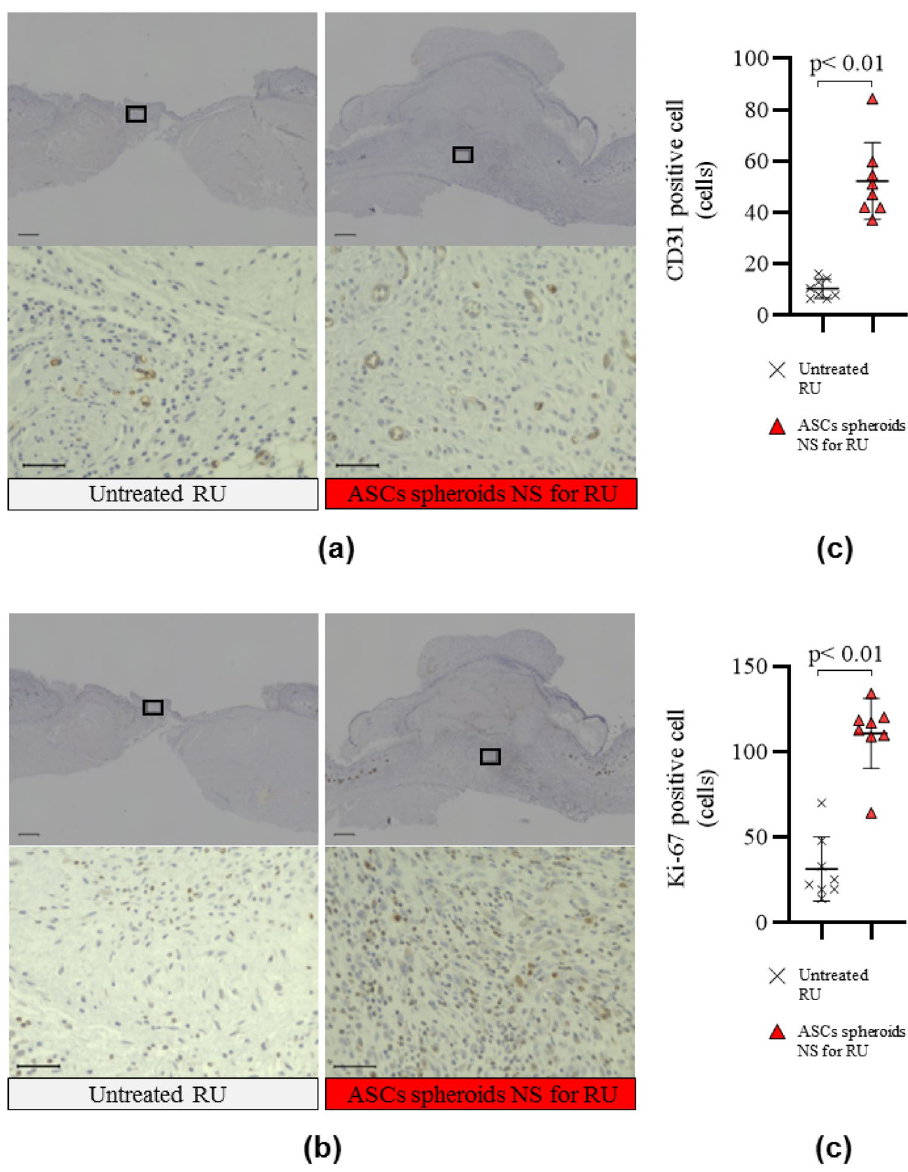
Figure 7. Immunohistological examination using CD31 and Ki-67 antibodies. Angiogenesis (CD31) ( a ) and cell proliferation (Ki-67) ( b ) in the skin wound were analyzed immunohistologically (representative images). Photographs shown in the lower panel are enlarged images of black boxes in the upper panels. Scale bars in the upper panels and lower panels are 500 μm and 50 μm, respectively. Numbers of CD31-positive cells ( c ) and Ki-67-positive cells ( d